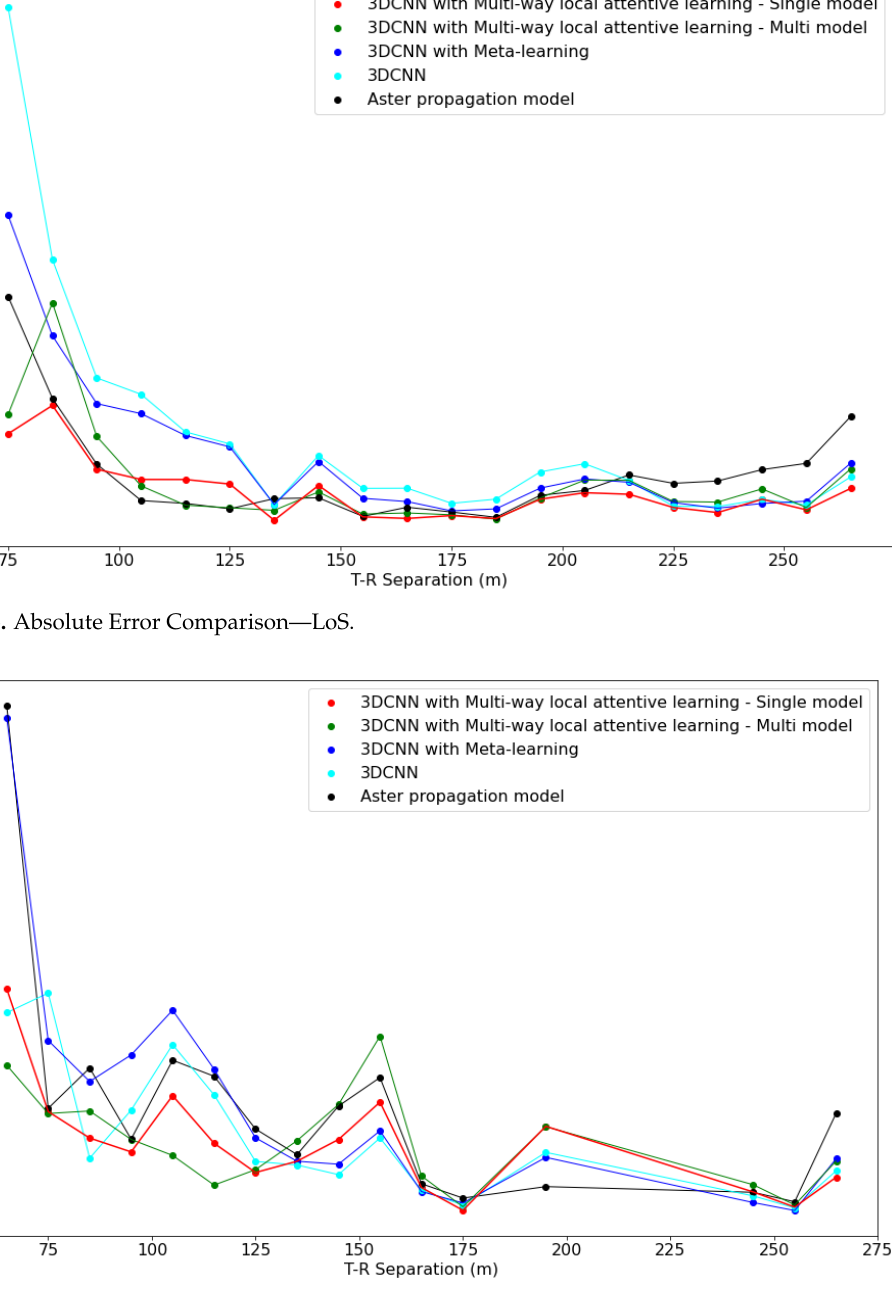
Figure 6. Absolute Error Comparison — NLoS. Table 7. Comparison Root Mean Square Error of various